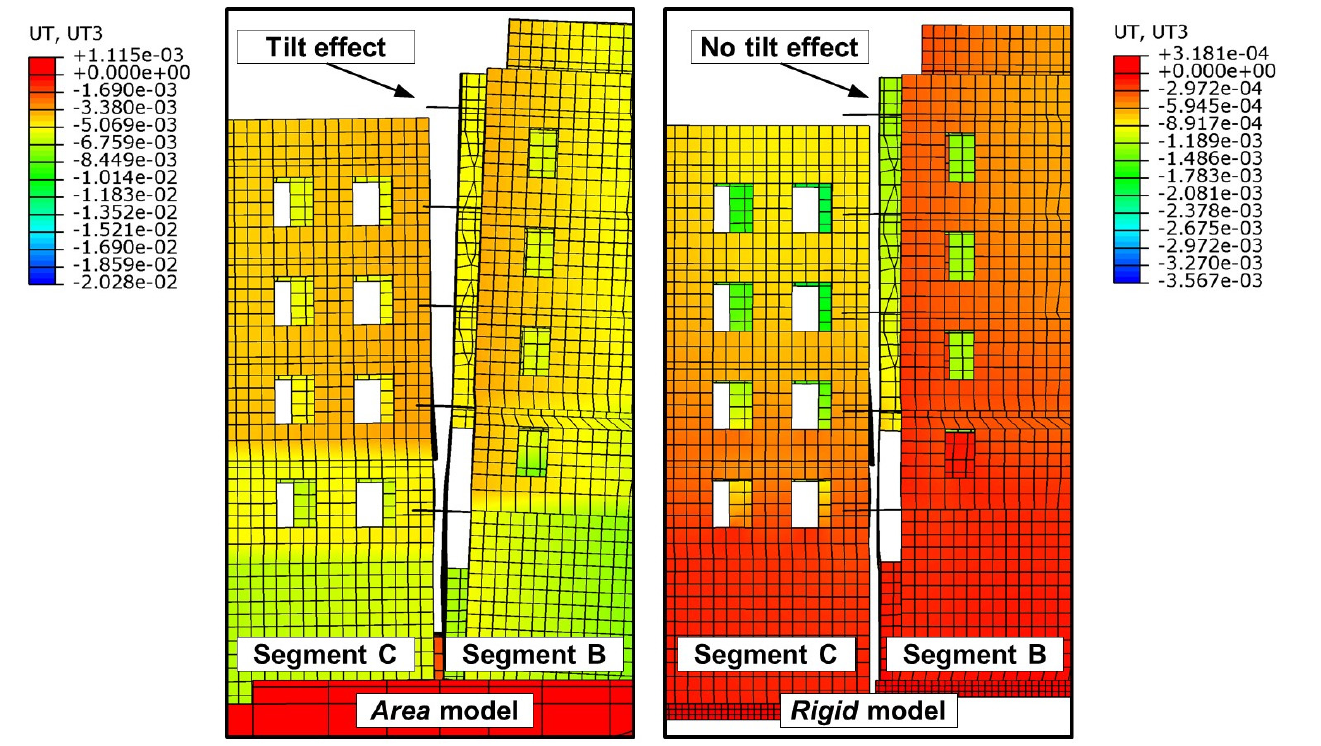
Figure 19. Displacement [m] of the building in the expansion joints between segments B and C for the AREA and RIGID models.